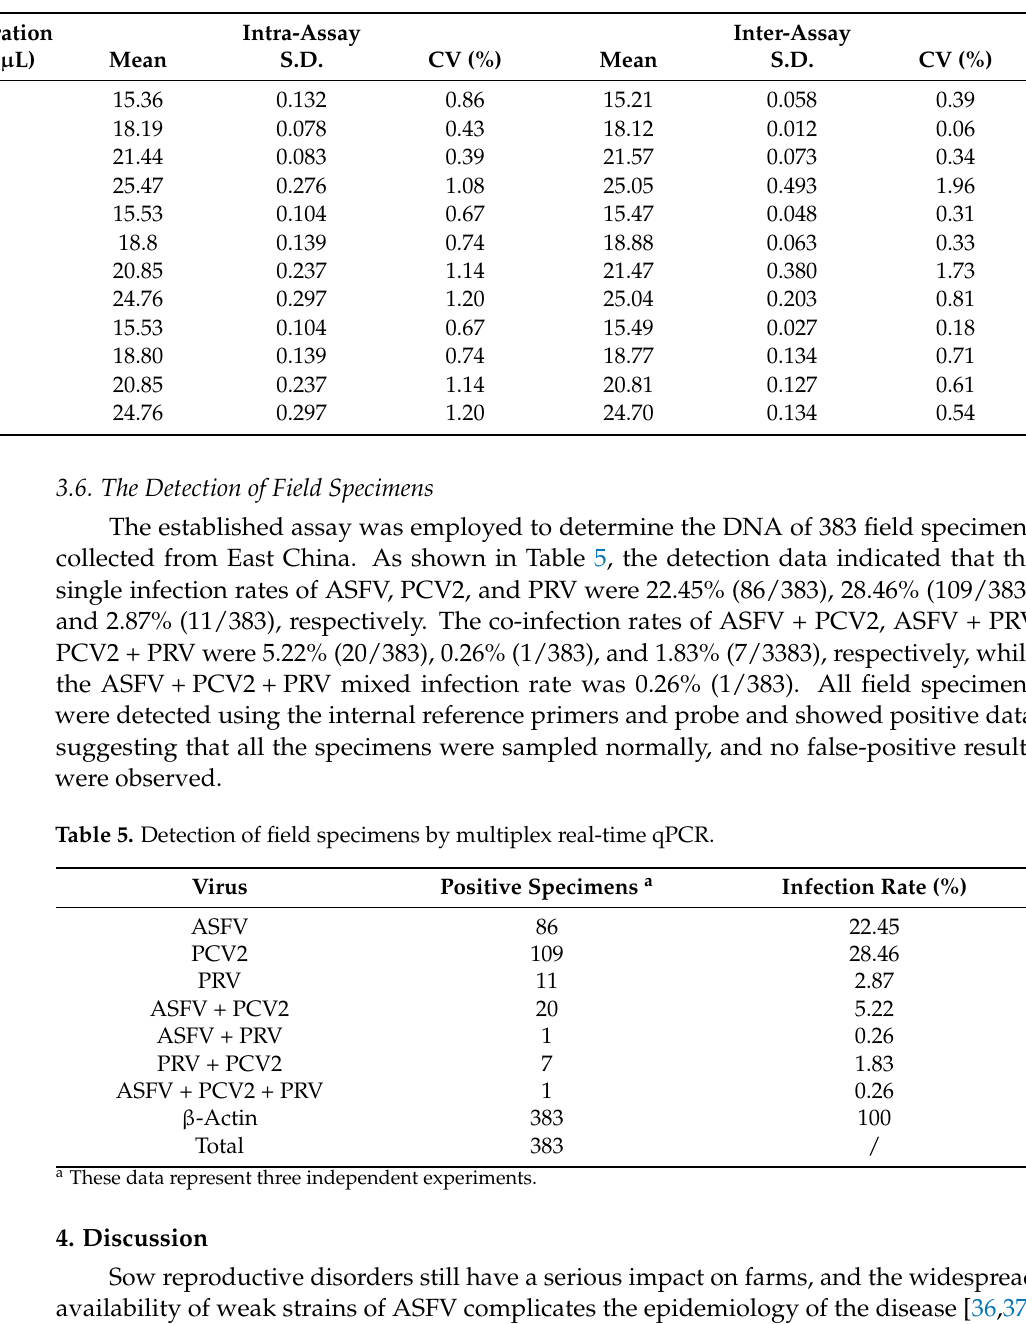
Table 4. Repeatability analysis of the multiplex real-time qPCR.